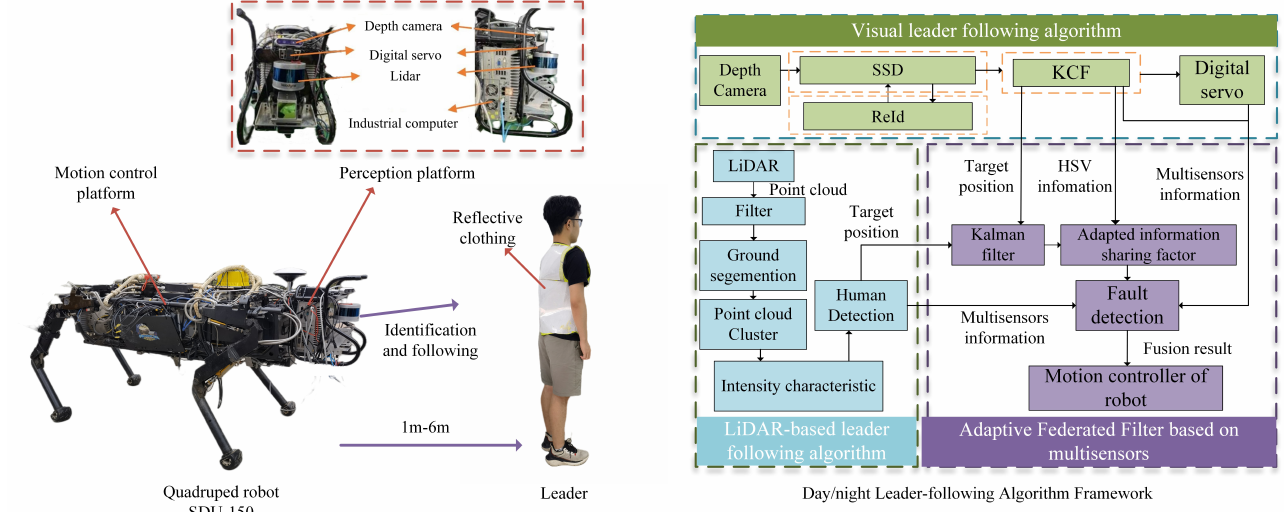
Figure 2. Quadruped robot SDU-150 (Shandong University, Jinan, China) is composed of perception and motion control platforms. The quadruped robot perception platform reveals the positional relationship between the depth camera and the LiDAR. The leader wears reflective clothing and maintains a distance of 1m to 6m from robot. The day/night leader-following algorithm framework includes visual leader-following, LiDAR-based leader-following, and Adaptive Federated